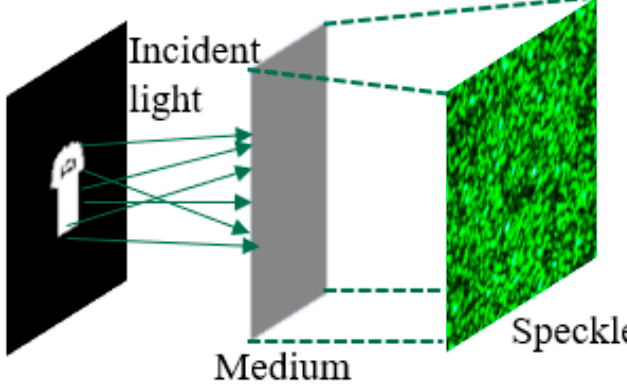
Figure 1. Principle of scatter imaging.